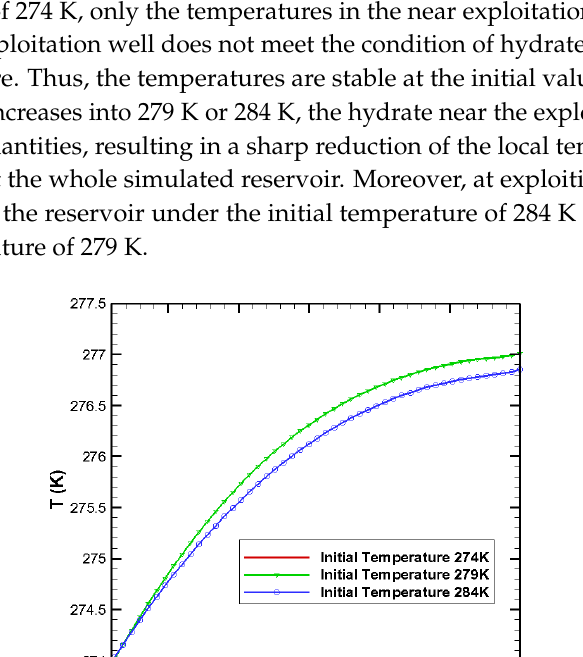
Figure 5. Comparison of temperature distributions in reservoirs under well pressure of 3 MPa, and different initial temperatures (274 K, 279 K, and 284 K) at exploiting time of 300 min.